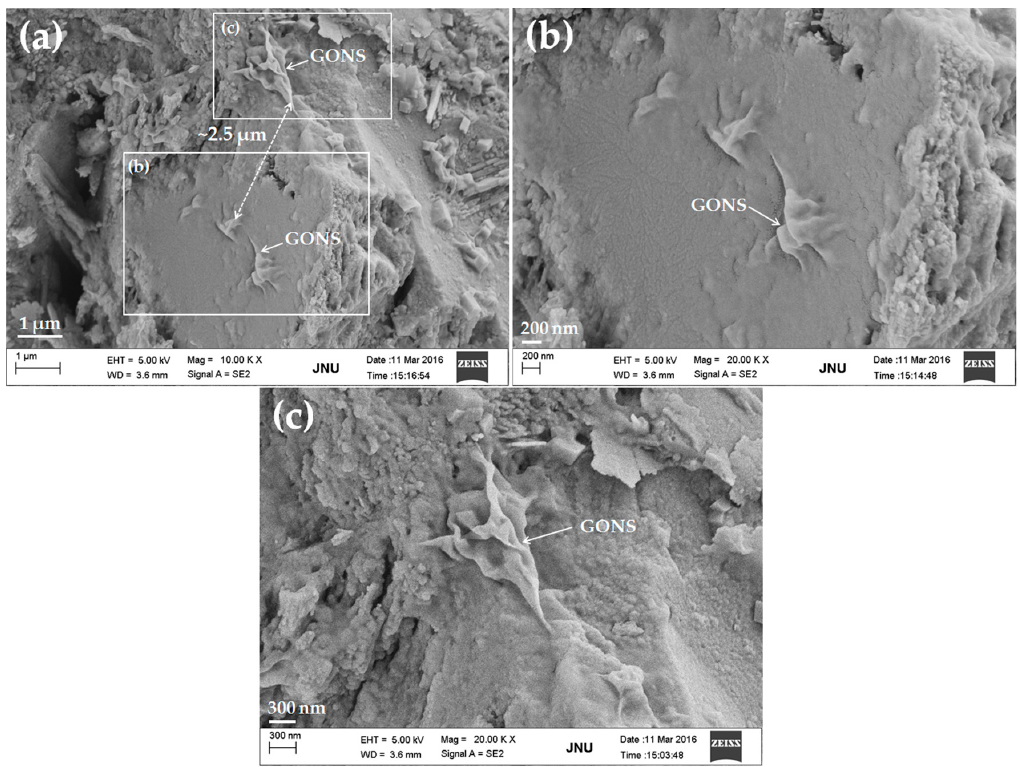
Figure 10. SEM images of GONSs in the GONS-incorporated UHSC sample: ( a ) Some existing GONSs individually observed on the surface; ( b ) the local amplification for one GONS in the white box marked in image ( a ); and ( c ) the local amplification for another GONS in the white box marked in image ( a ).